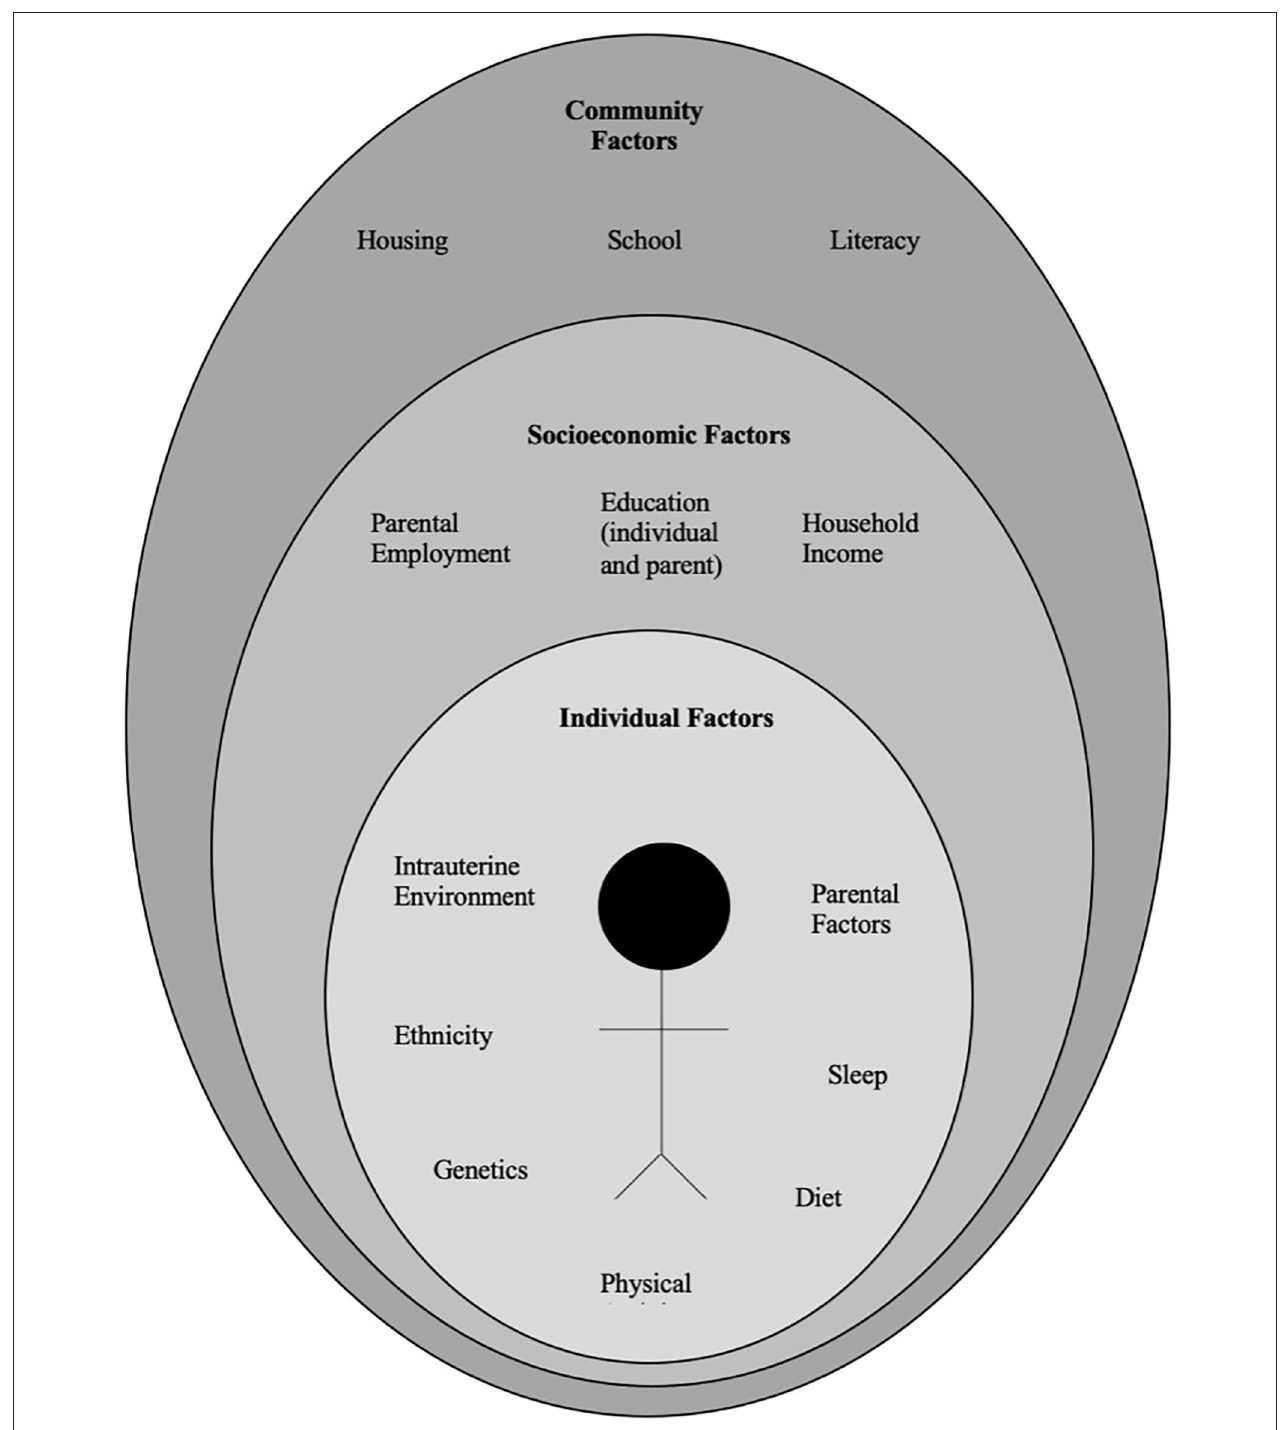
FIGURE 1 | Multidimensional factors contributing to child and adolescent obesity.